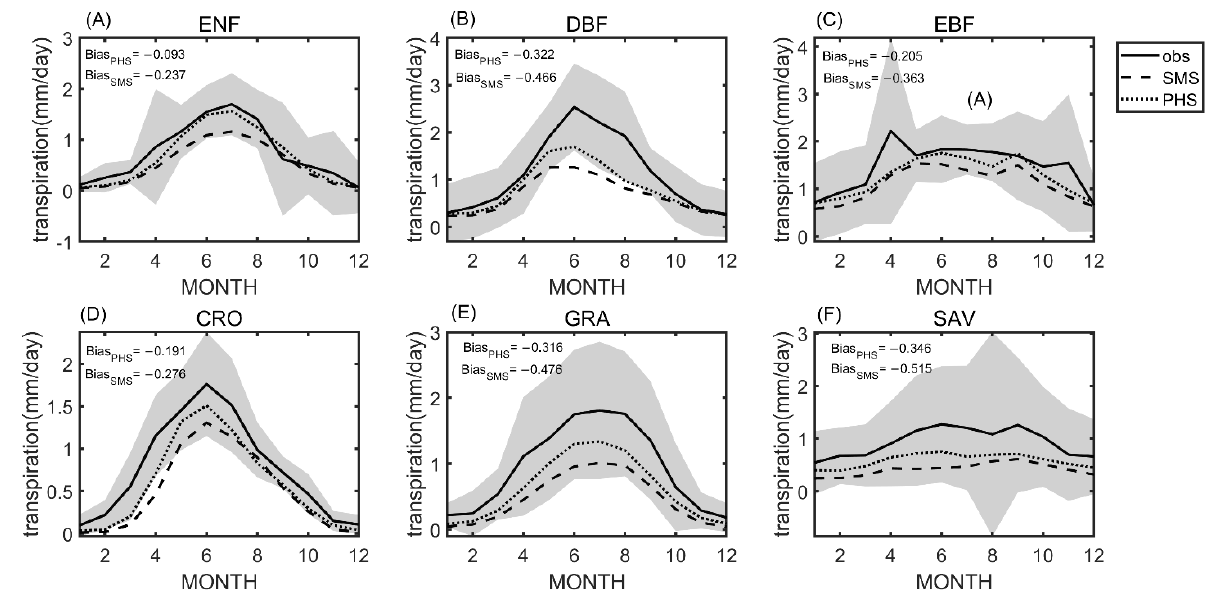
Figure 3. Seasonal variation in transpiration. The climatologic mean in transpiration is the average over all site-year seasonal variations, which is grouped into six plant types (( A ), evergreen needleleaf forest; ( B ), deciduous broadleaf forest; ( C ), evergreen broadleaf forest; ( D ), cropland; ( E ), grassland; ( F ), savanna). The shadow is the standard deviation of the observation. The Bias PHS is the annual mean difference in the transpiration of the observation and PHS, and the Bias SMS is the annual mean difference in the transpiration between the observation and SMS.